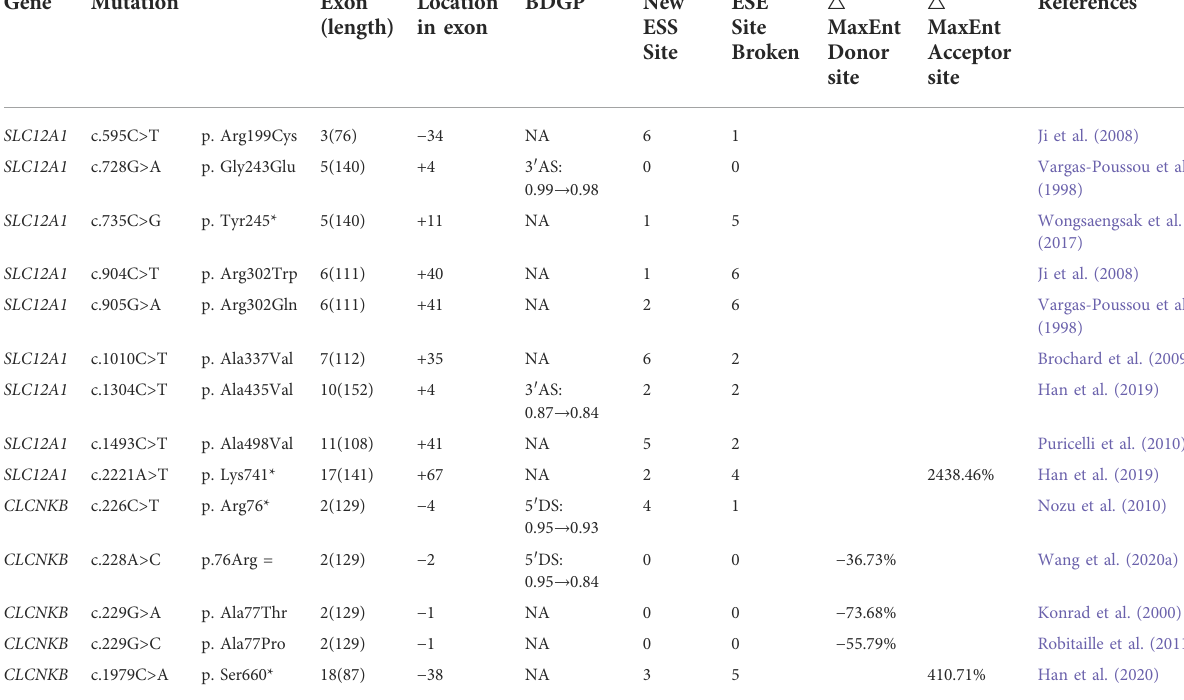
TABLE 1 Variants selected from this study in SLC12A1 and CLCNKB , and the results of silico analyses.